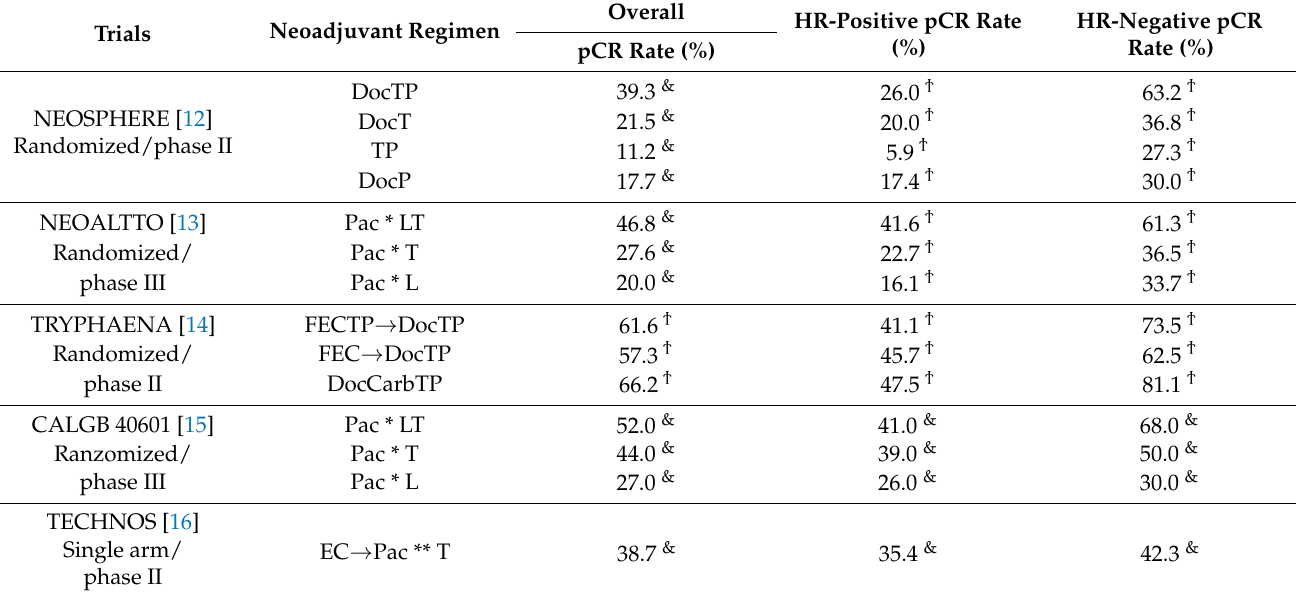
Table 1. Pathological complete response rates in HER2-positive breast cancer clinical trials accord- ing to hormone receptor